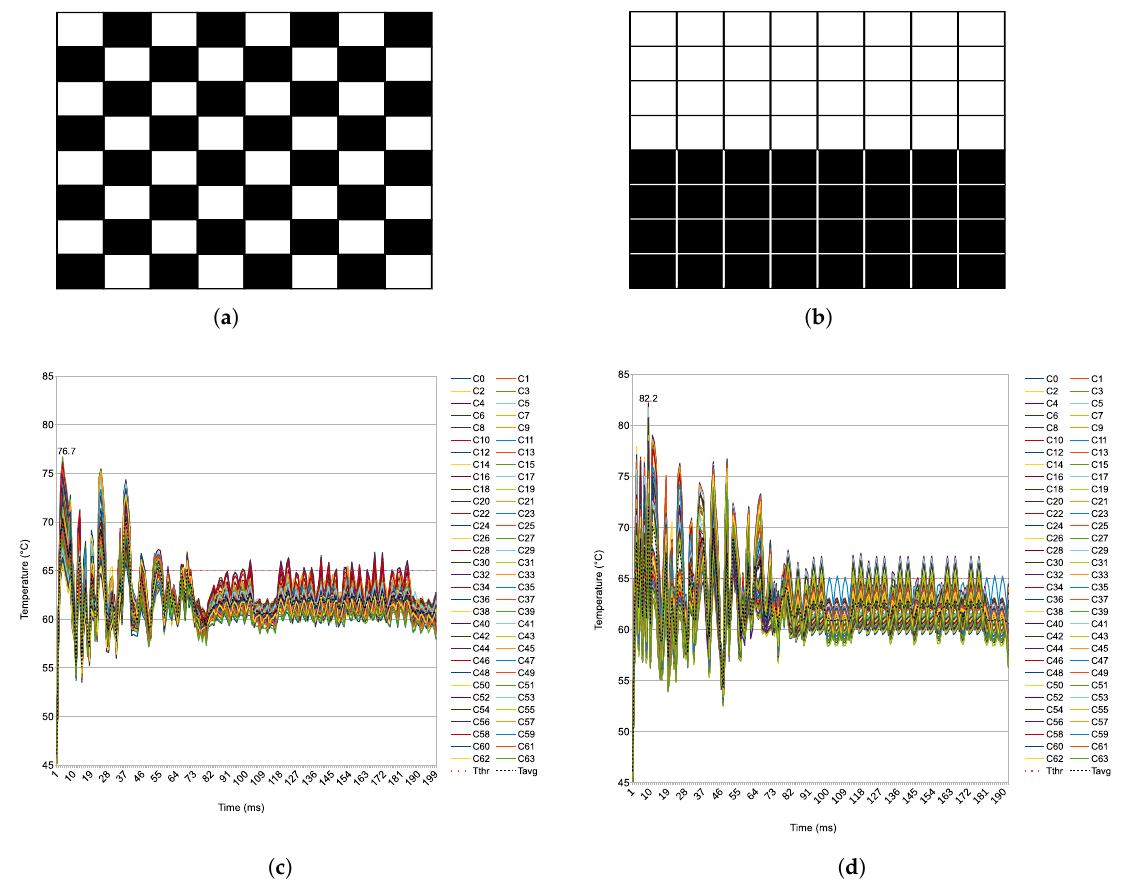
Figure 9. Transient temperature and active and dark cores patterns: ( a ) chessboard pattern; ( b ) contiguous pattern; ( c ) transient temperature for chessboard pattern; and ( d ) transient temperature for contiguous pattern.